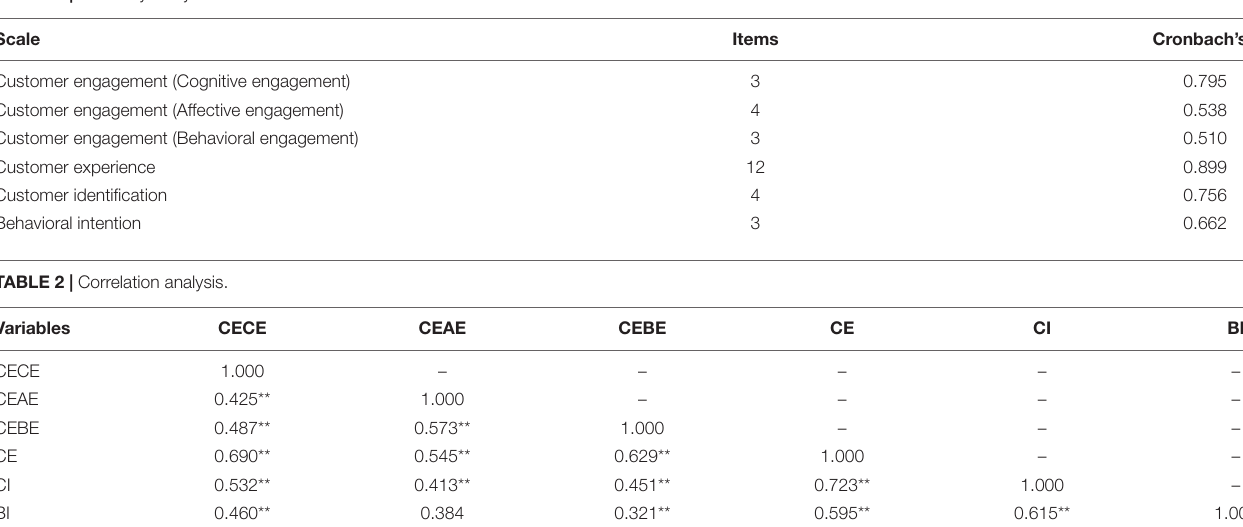
TABLE 1 | Reliability analysis.